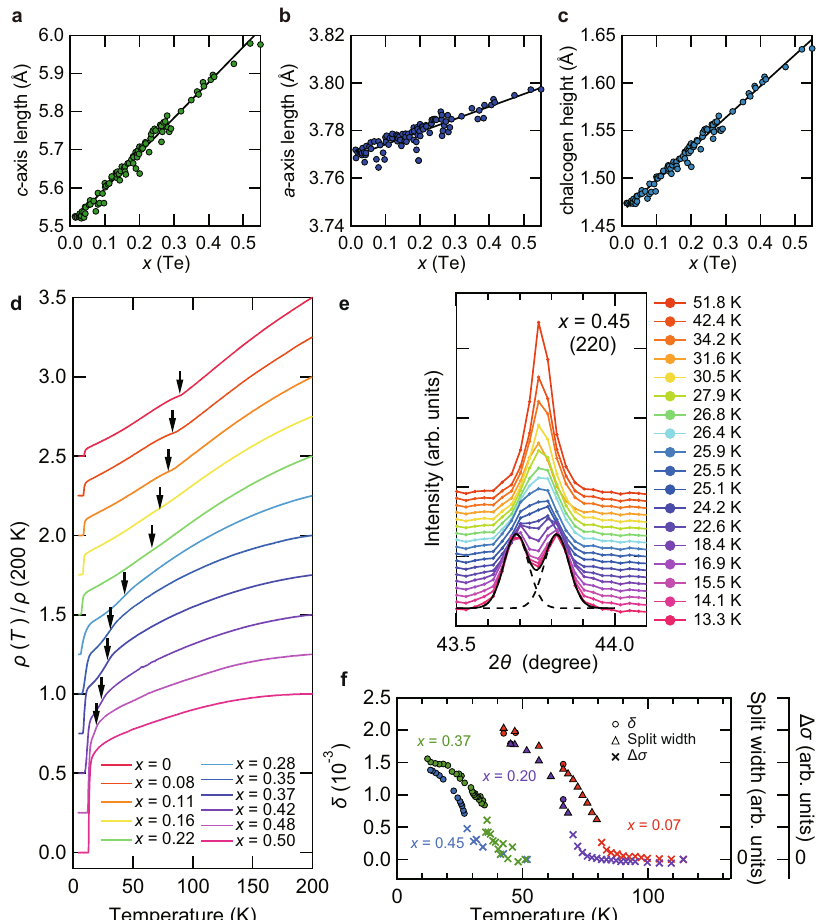
Fig. 1 Evolution of structural parameters and resistivity with Te composition in single crystals of FeSe 1 − x Te x at ambient pressure. a – c Lattice parameters and Te composition x (Te) determined by X-ray diffraction (XRD). Lattice constants c ( a ) and a ( b ) as well as the chalcogen height from the Fe plane ( c ) are shown as a function of x (Te). Solid line represents the linear x (Te) dependence (Vegard ’ s law). d Temperature dependence of the in-plane resistivity ρ normalized by the value at 200 K for 0 ≤ x (Te) ≲ 0.50. Each curve is shifted vertically for clarity. The resistive anomalies associated with the nematic transition temperature T s (black arrows) are determined by the minimum (0 ≤ x (Te) ≲ 0.22) or the maximum (0.28 ≲ x (Te) ≲ 0.50) of the derivative curves d ρ ( T )/d T . e XRD intensity as a function of the scattering angle 2 θ near the (220) Bragg peak measured at several temperatures for x ≈ 0.45. Each curve is shifted vertically for clarity. The black solid and dashed lines indicate the result of the two-peak fi tting for the data at 13.3 K. f The orthorhombicity δ = ( a o − b o )/( a o + b o ) estimated from the two-peak fi tting of ( hk 0) Bragg peaks for x (Te) ≈ 0.07, 0.20, 0.37, and 0.45 (circles, left axis) and the split width of ( hkl ) Bragg peaks for x (Te) ≈ 0.07 and 0.20 (triangles, right axis) as a function of temperature. We also plot additional width Δ σ of single peak near the transition (crosses, right axis), estimated by the standard deviation σ of the single Gaussian fi tting subtracted by the value at the maximum temperature measured for each